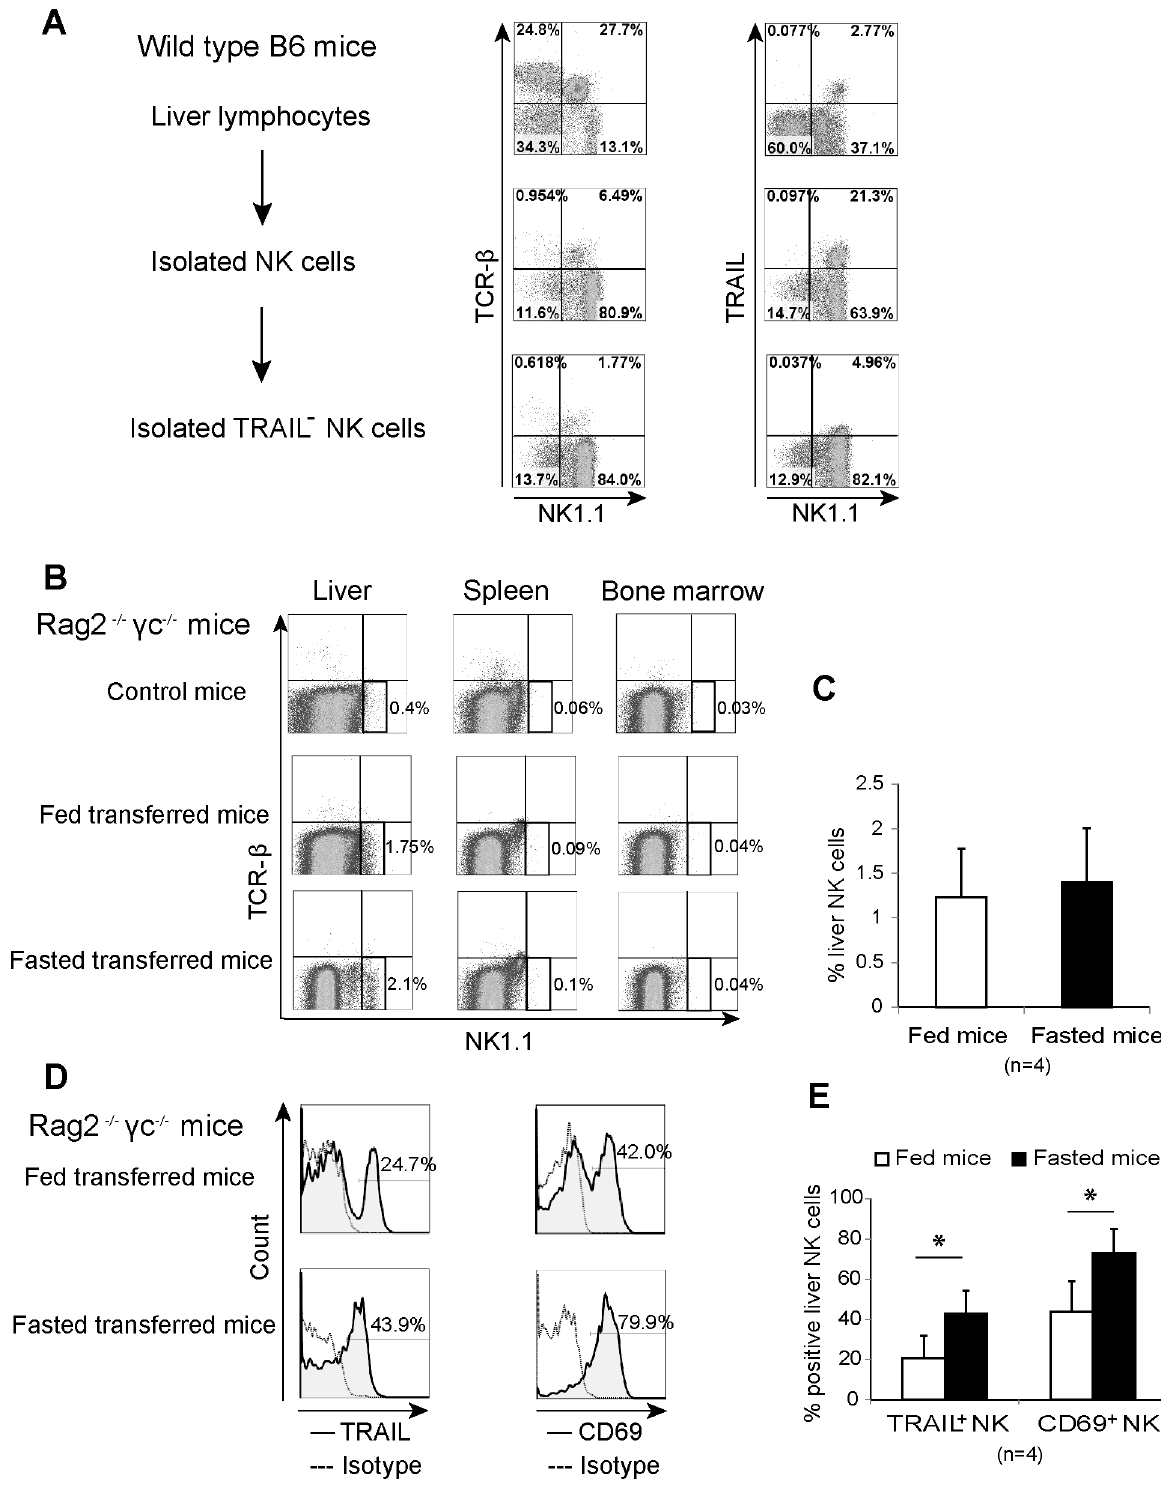
Figure 4. Adoptive transfer assay for TRAIL and CD69 expression on liver natural killer cells in response to starvation. (A) Isolated TRAIL 2 natural killer (NK) cells were separated from liver lymphocytes of wild type B6 mice. Proportion of lymphocytes expressing TCR b , NK1.1, and TRAIL in whole liver lymphocytes, isolated NK cells, and isolated TRAIL 2 NK cells are presented in dot plots. The isolated TRAIL 2 NK cells were adoptively transferred into Rag-2 2 / 2 c chain 2 / 2 mice (0.5 6 10 6 cells/mouse), which were then fed or fasted for 3 days before determining their NK phenotype. (B) Dot plots show the gated TCR b 2 NK1.1 + NK cells and their percentage in the liver, spleen, and bone marrow of non-transferred (control), fed-transferred, and fasted-transferred mice. (C) Bar graph presents the mean percentage plus standard deviation of NK cells in the liver of fed and fasted-transferred mice. (D) Expression of TRAIL and CD69 (solid lines) on the liver NK cells of representative fed- and fasted-transferred mice